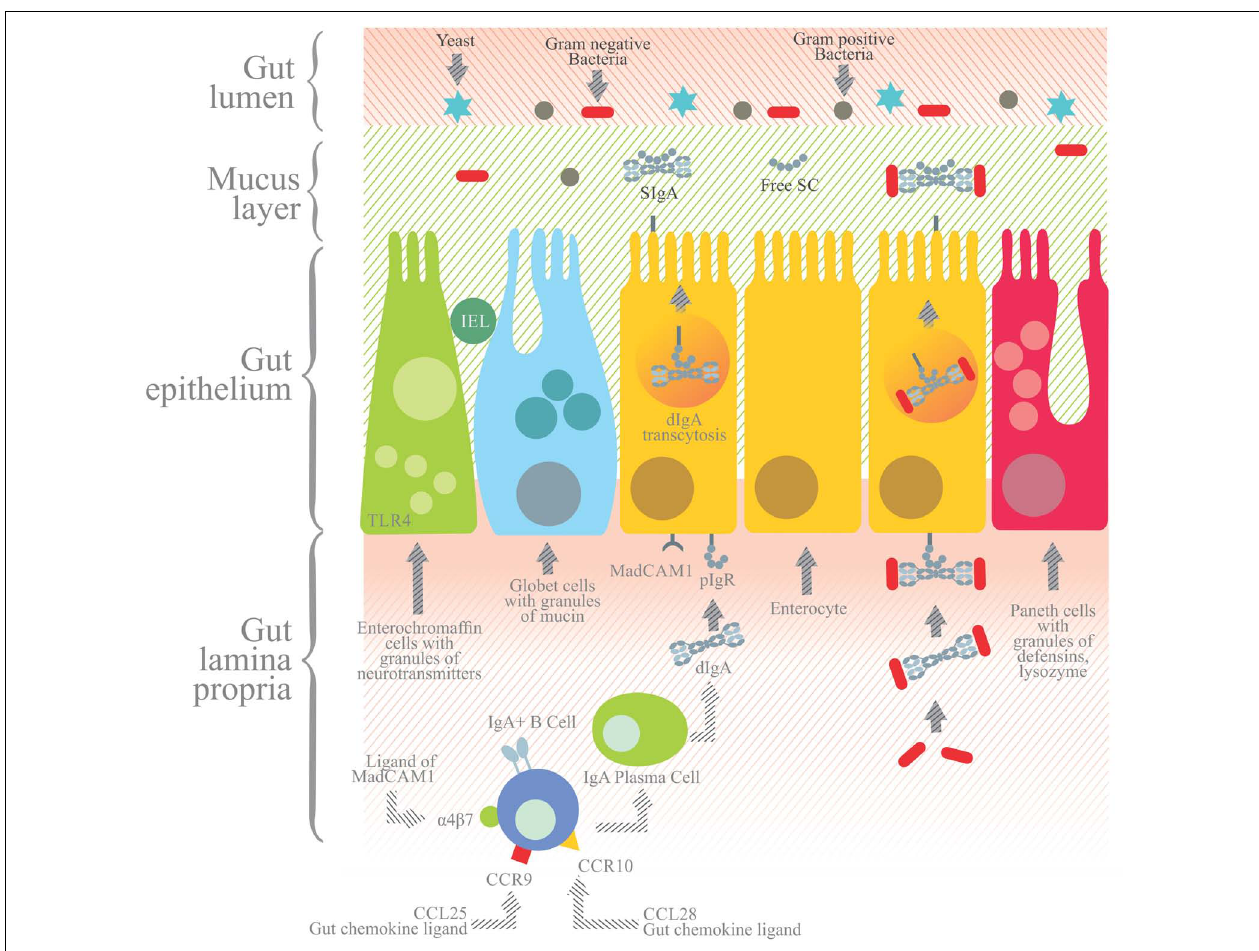
FIGURE 4 | In the gut lamina propria, IgA+ B cells further differentiate into IgA+ plasma cells that secrete dIgA or pIgA antibodies joined by the J chain. dIgA or pIgA are captured by the polymeric immunoglobulin receptor (pIgR), a transmembrane receptor with five extracellular domains and an intracellular tail expressed at the basolateral side of the enterocytes. The dIgA-pIgR complex is internalized and transported by transcytosis to the apical side, and the extracellular portion of pIgR with five domains is proteolytically cleaved from the transmembrane region.